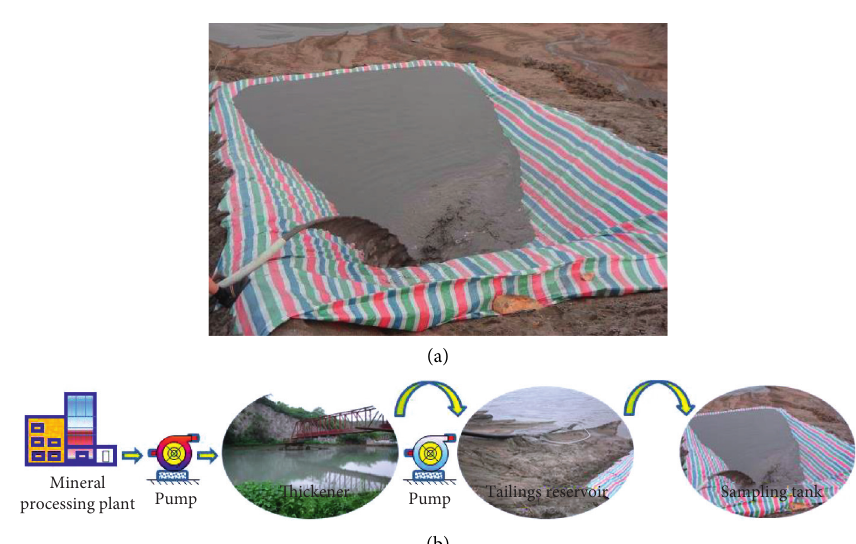
Figure 1: The tailings sampling.